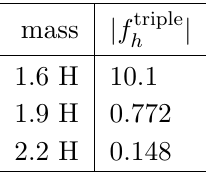
Table 5 . NG mediated by h via triple exchange diagram in e(cid:11)ective Goldstone description. slow-roll in(cid:13)ation, using lagrangian (5.6), F double takes an identical form to (B.31) h